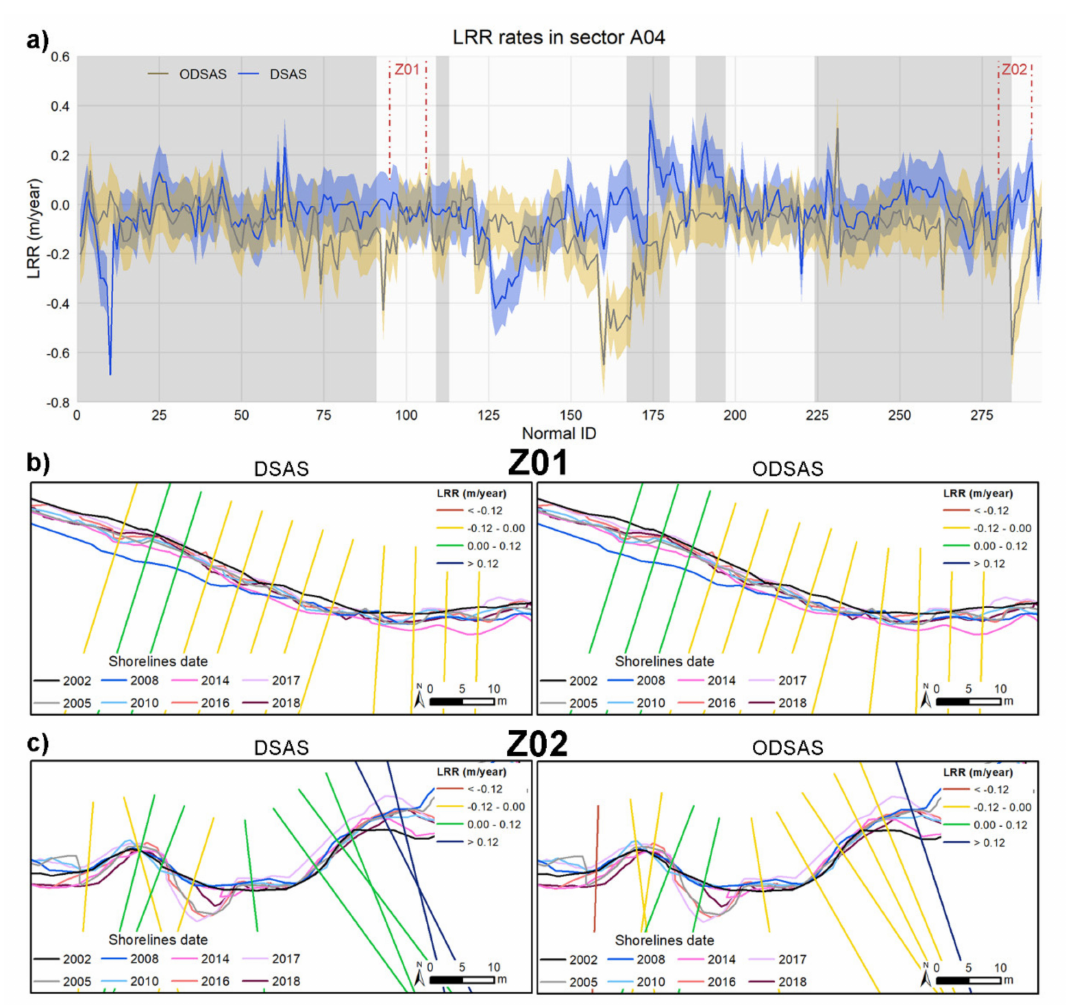
Figure 7. Variations in LRR values obtained using the DSAS and ODSAS approach: ( a ) the solid line represents the LRR value for each method at each transect and the colored area around the line represents one standard deviation level. The gray background indicates curvilinear coastlines, and white, the rectilinear coastline sections; ( b , c ) show the shape of the historical coastlines and transects for the zoomed sections Z01 and Z02, which location is indicated by the red dashed lines in ( a